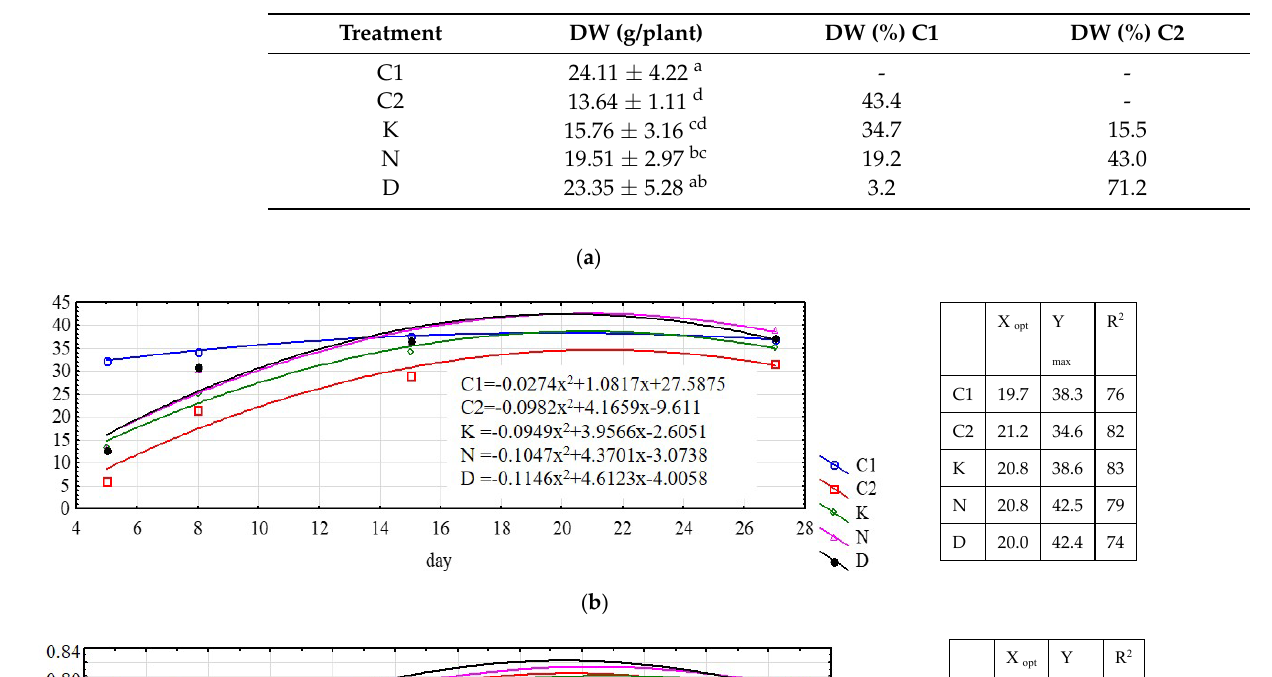
control treatment under normal growth conditions without cold stress (DW (%) C1), dry weight of